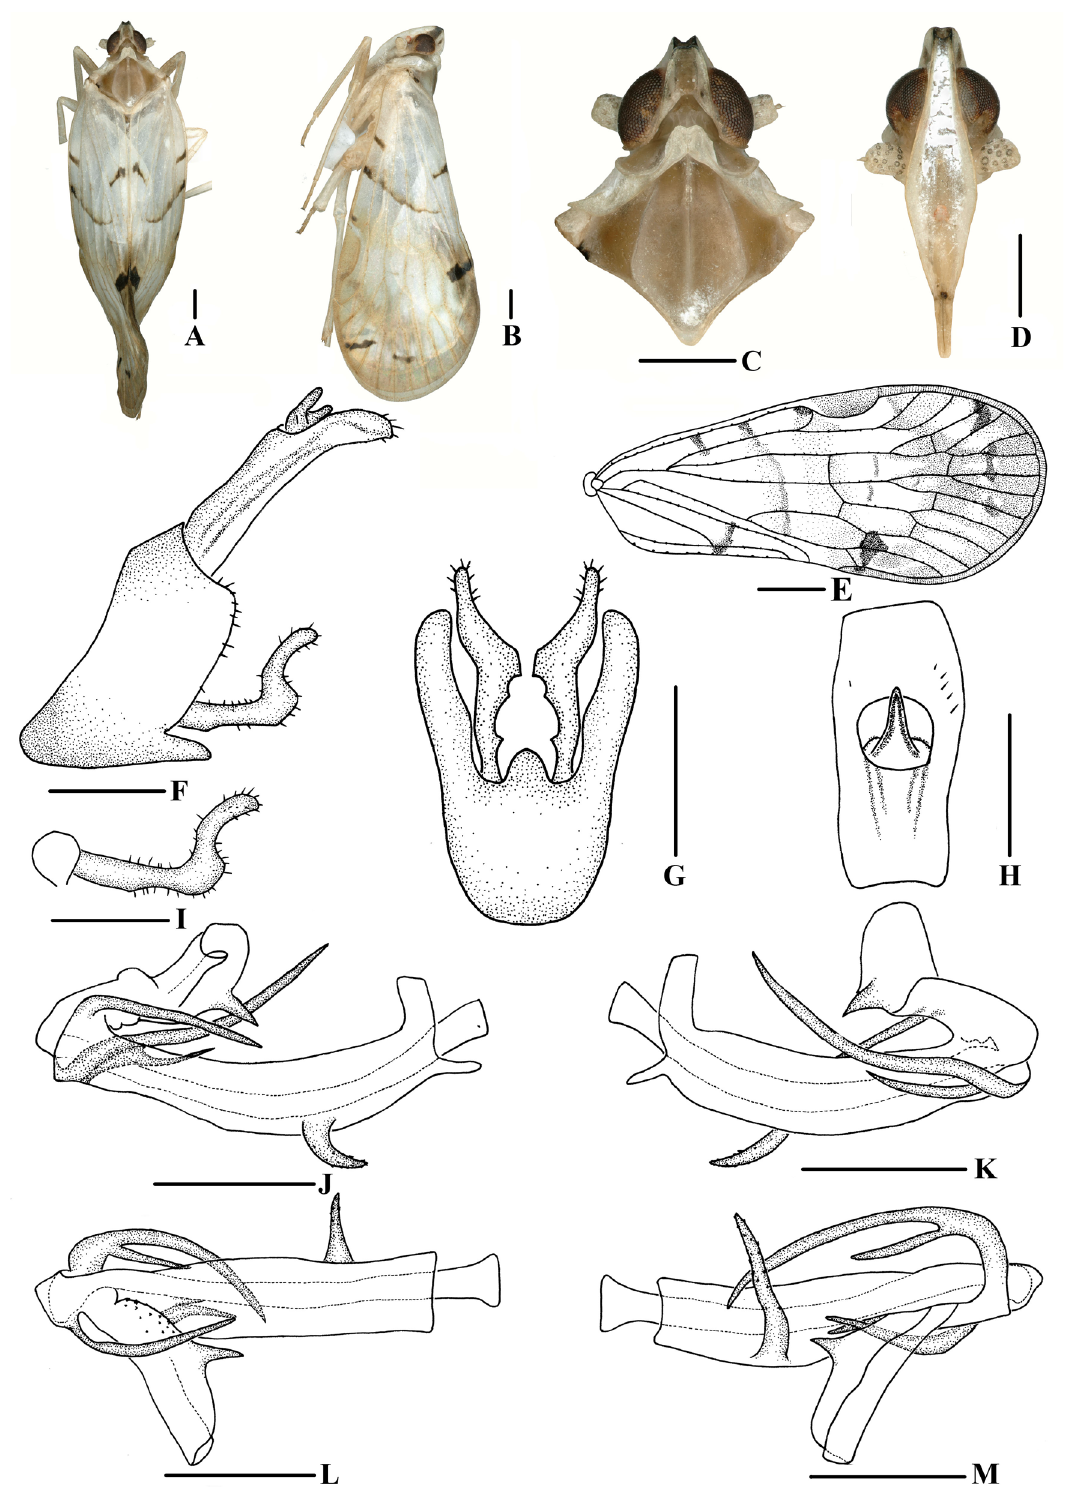
Fig. 9. Andes pallidus Wang & Chen sp. nov., ♂. A . Dorsal view. B . Lateral view. C . Head and thorax, dorsal view. D . Face, ventral view. E . Forewing. F . Genitalia, lateral view. G . Pygofer and gonostyli, ventral view. H . Anal segment, dorsal view. I . Gonostyli, lateral view. J . Aedeagus, right side. K . Aedeagus, left side. L . Aedeagus, dorsal view. M . Aedeagus, ventral view. Scale bars: A–D, F–M = 0.5 mm; E = 1.0